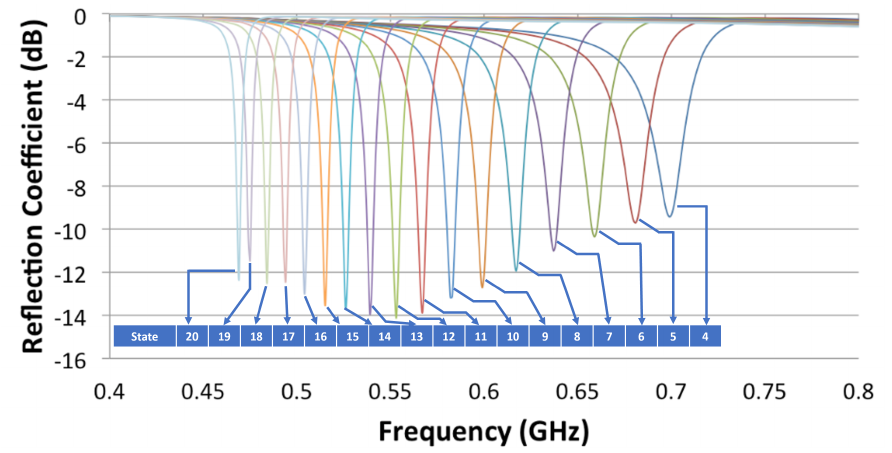
Figure 5. Simulated antenna reflection coefficient.